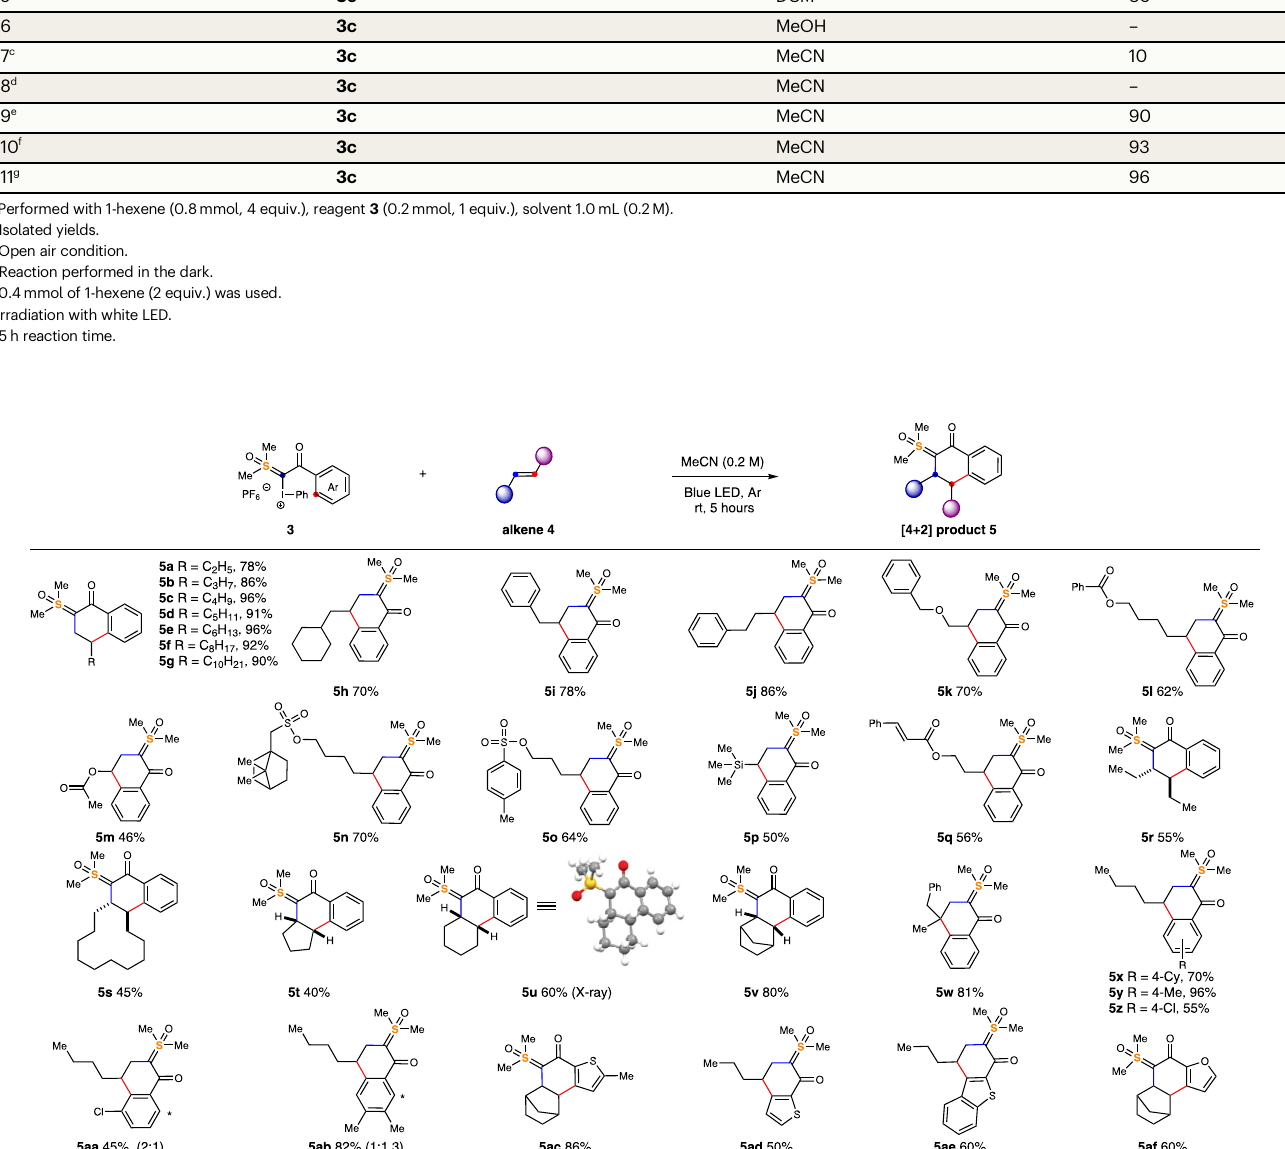
irradiation of blue LED for 5h, isolated yields. See Supplementary Methods for experimental